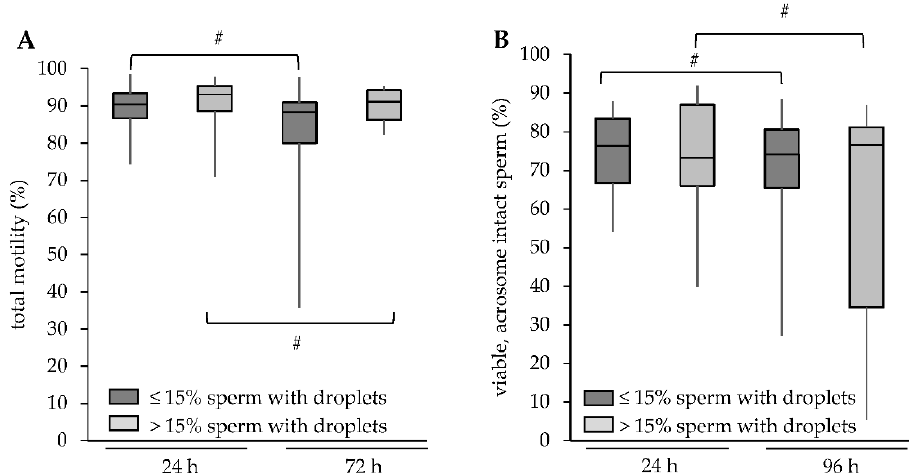
Figure 4. Storage effect on motility and viability in relation to the presence of sperm with cytoplasmic droplets. Change in ( A ) motility and ( B ) viable, acrosome-intact spermatozoa with increasing storage time at 17 ◦ C. A hash (#) indicates significant differences ( p < 0.05) between the two storage times for samples with ≤ 15% of spermatozoa with cytoplasmic droplets (CD; n = 66 boars) or samples with >15% of spermatozoa with cytoplasmic droplets (n = 12 boars). A hash indicates significant differences between storage times ( p < 0.05).